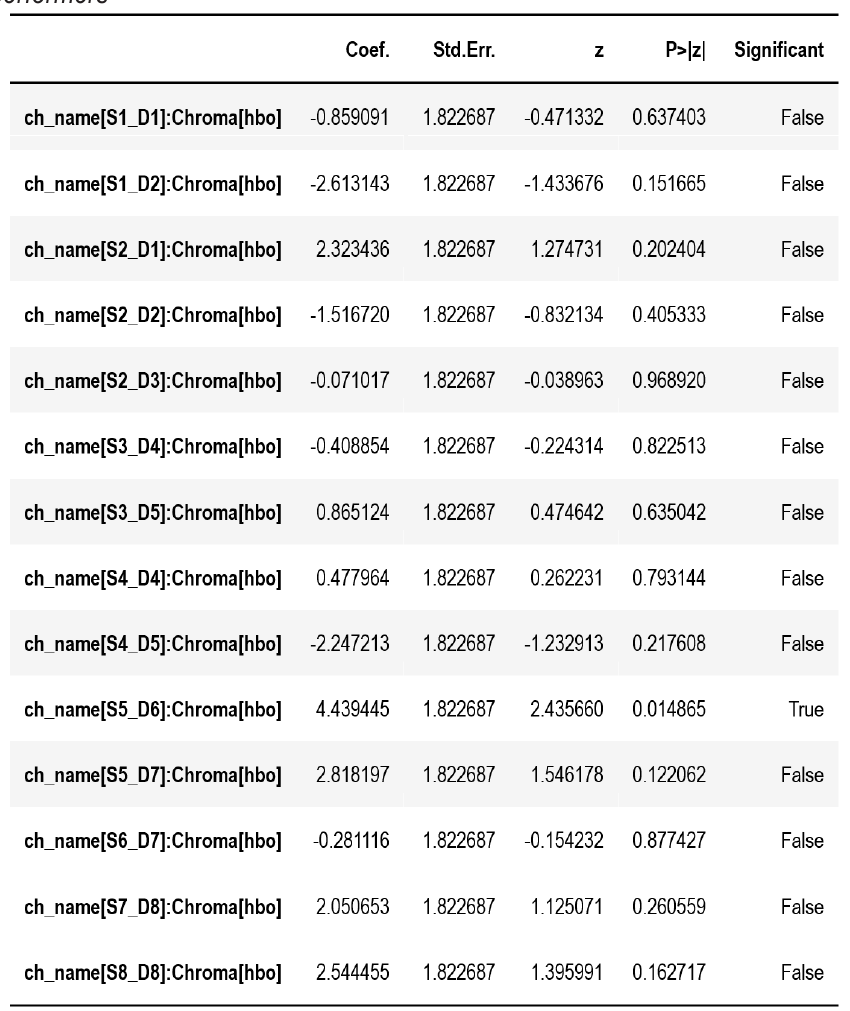
Beta coefficients of second level of GLM contrast “word versus a numerical format of calculation” in low level